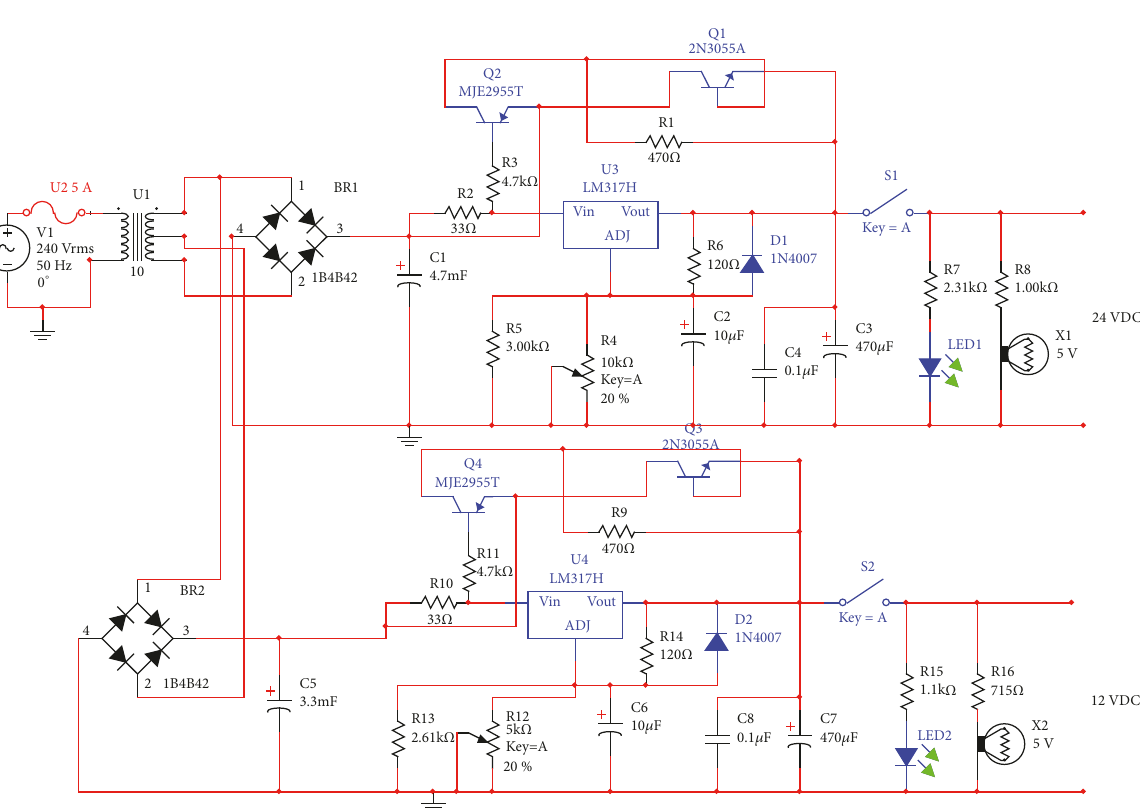
Figure 10: Dual voltage regulated power supply (+12 / +24